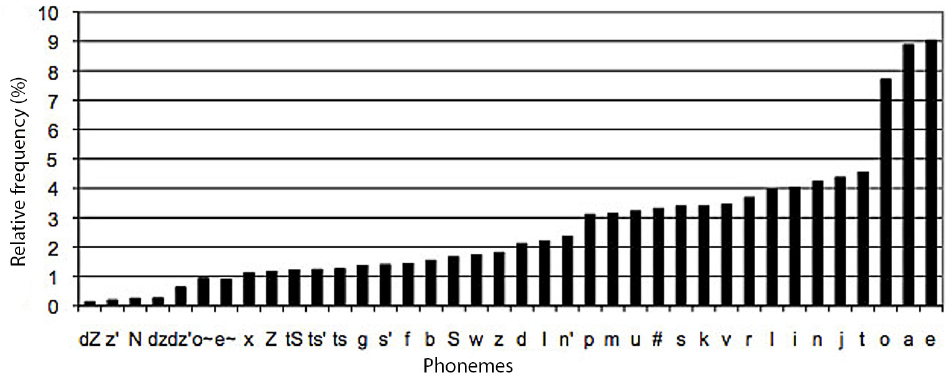
Figure 2. Phoneme frequency distribution in the final version of the corpus.